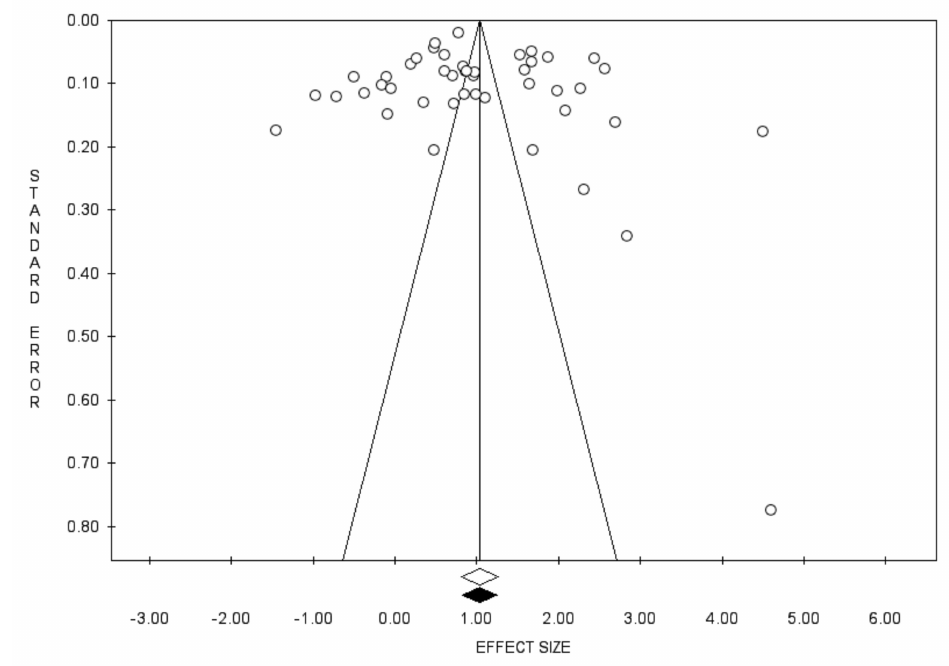
Figure 3. Funnel plot for the prevalence of seroprotection.